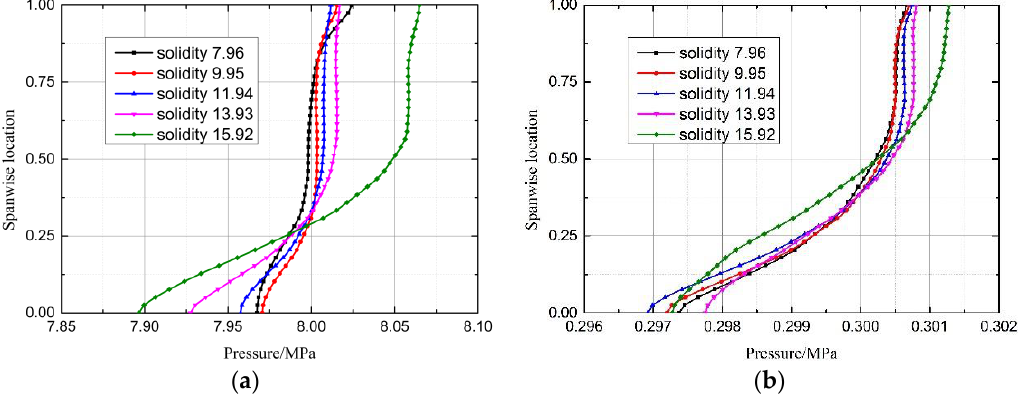
Figure 11. Averaged pressure along spanwise location at turbine outlet: ( a ) SCO 2 ; ( b ) air.